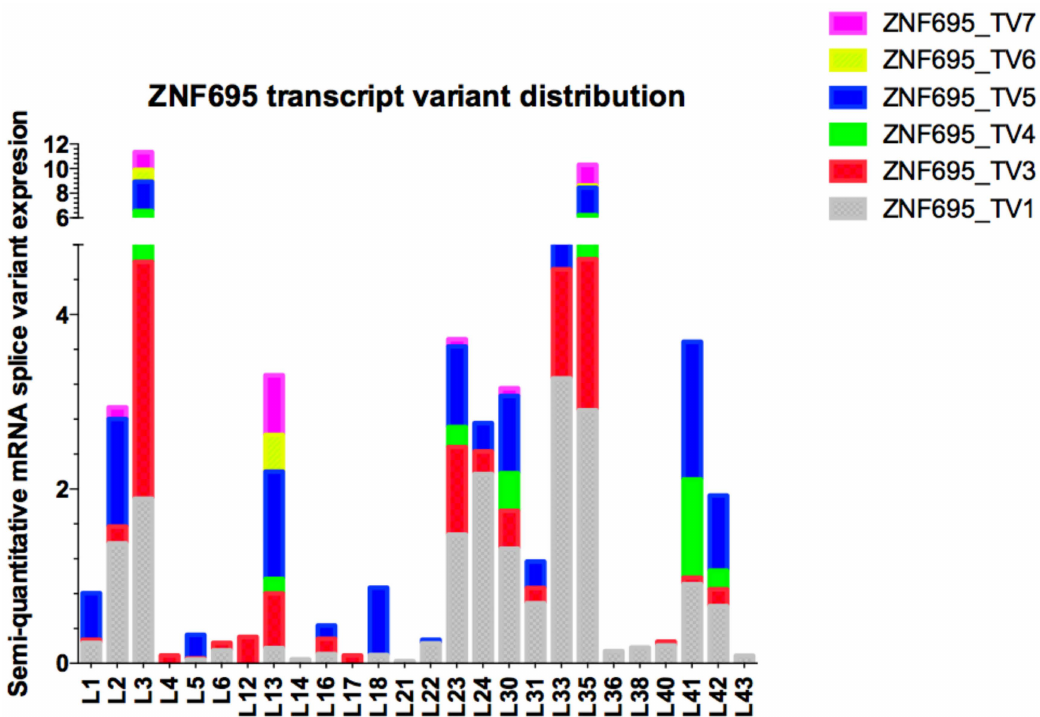
Figure 7. Semi-quantitative expression analysis of ZNF695 transcript variants expressed in B-ALL. The plot shows the diversity in the expression and co-expression of ZNF695 alternative splice variants in B-ALL. The color bars represent the ZNF695 transcript variants: gray bars indicate ZNF695_TV1, red bars indicate ZNF695_TV3, green bars indicate ZNF695_TV4, blue bars indicate ZNF695_TV5, yellow bars indicate ZNF695_TV6, and pink bars indicate ZNF695_TV7 expression.